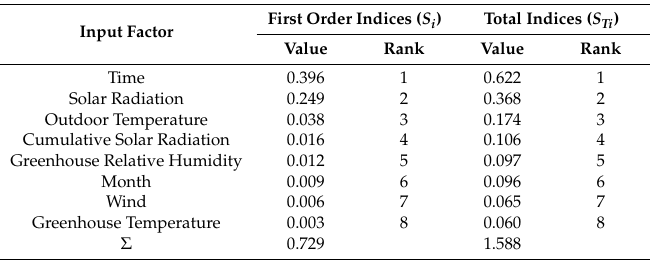
Table 2. First and Total Indices for all input factors in order of